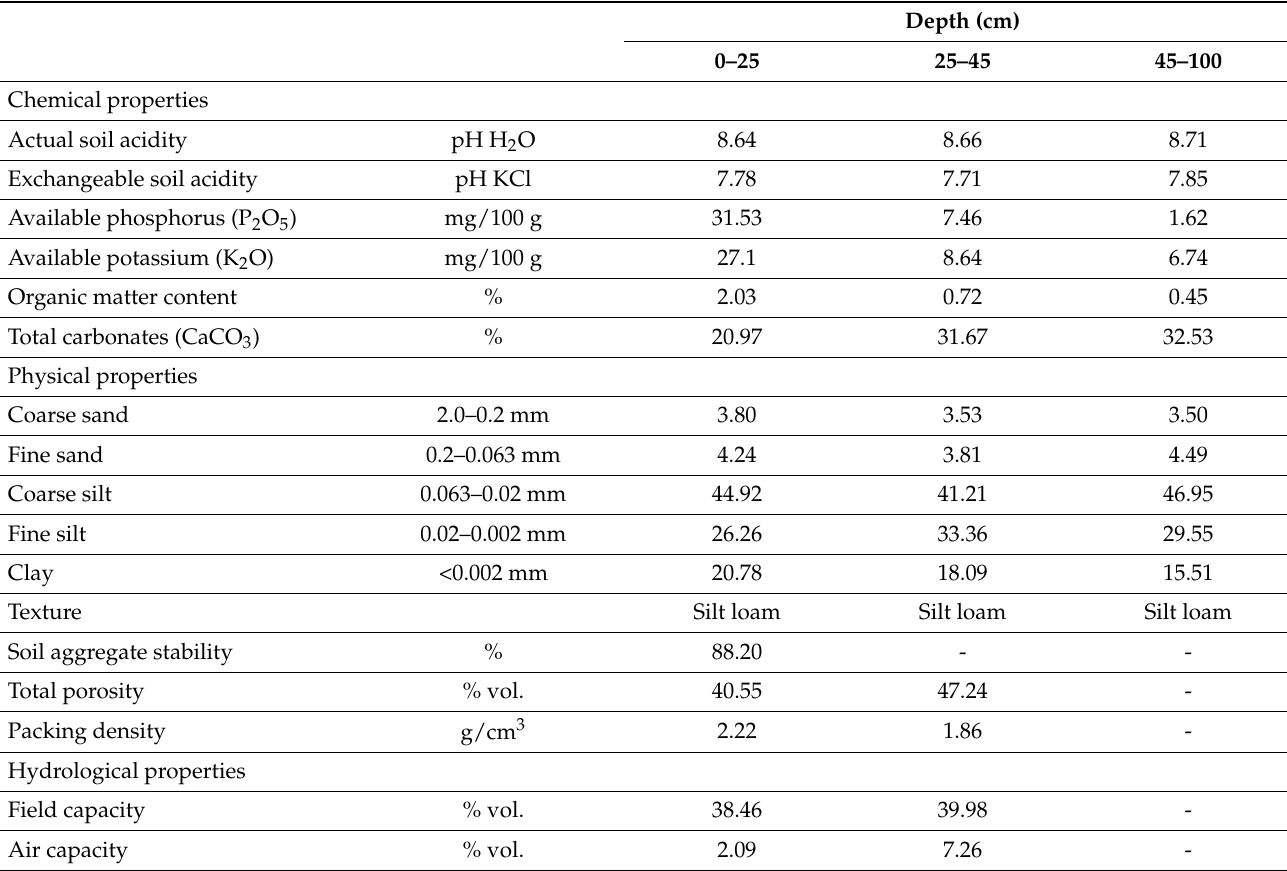
Table 4. Basic chemical, physical and hydrological properties of the investigated